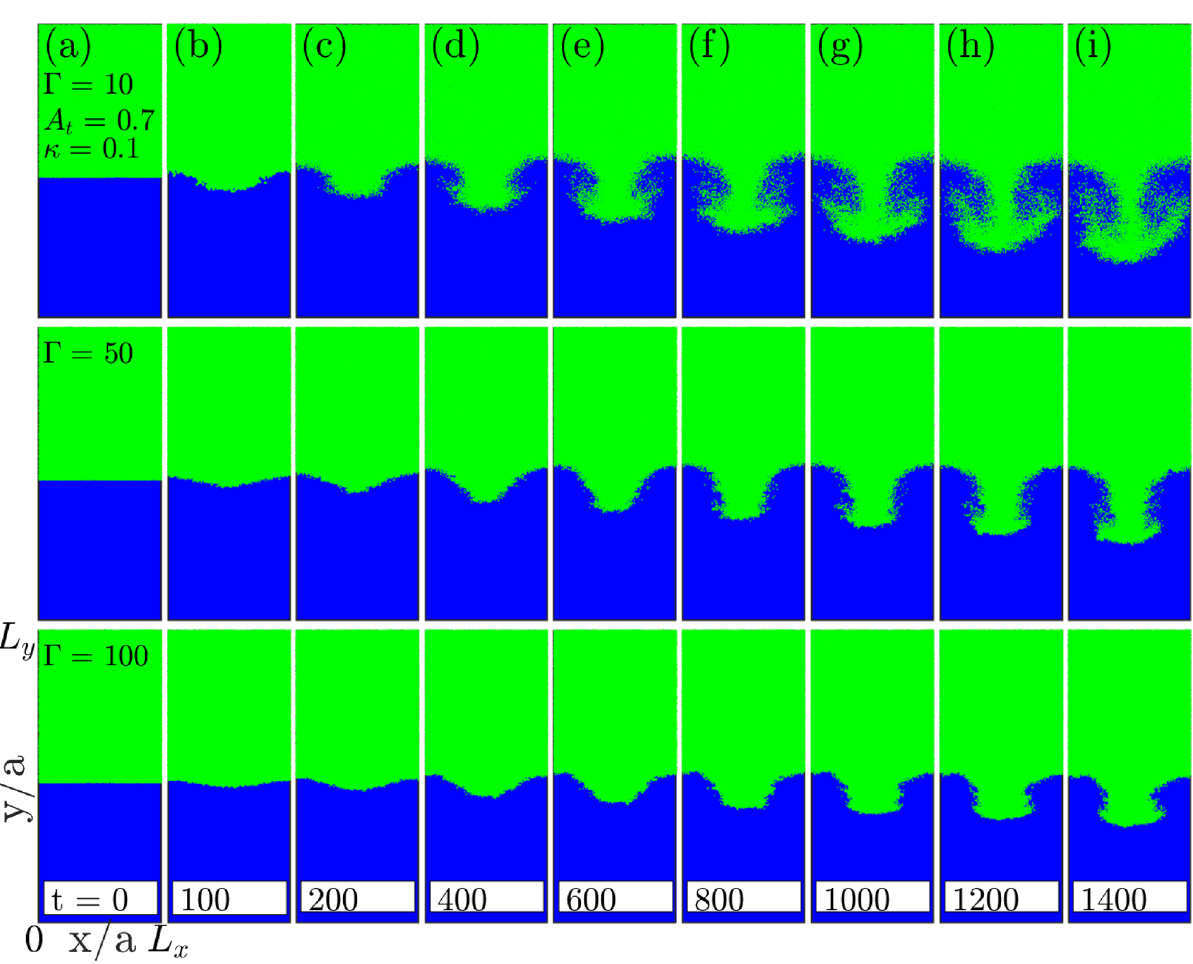
Figure 4. Effect of coupling strength Ŵ on single-mode RTI. The top to bottom rows shows the evolution of single-mode RTI in systems with increasing coupling (Coulomb) strength. The suppression of growth of the spike amplitude in single-mode RTI is clearly visible with increase in the coupling strength. ( a ) In each row at t = 0 ω − 1 t = 100 ω − 1 pl , shows the initial step density profile. The snapshots in each row are shown at pl ( b ) and 1 t = 200 ω − 1 t = 1400 ω − 1 rest all ( c – i ) with an interval of t = 200 ω − pl , from pl onward upto pl s. The related movie is provided in Supplementary